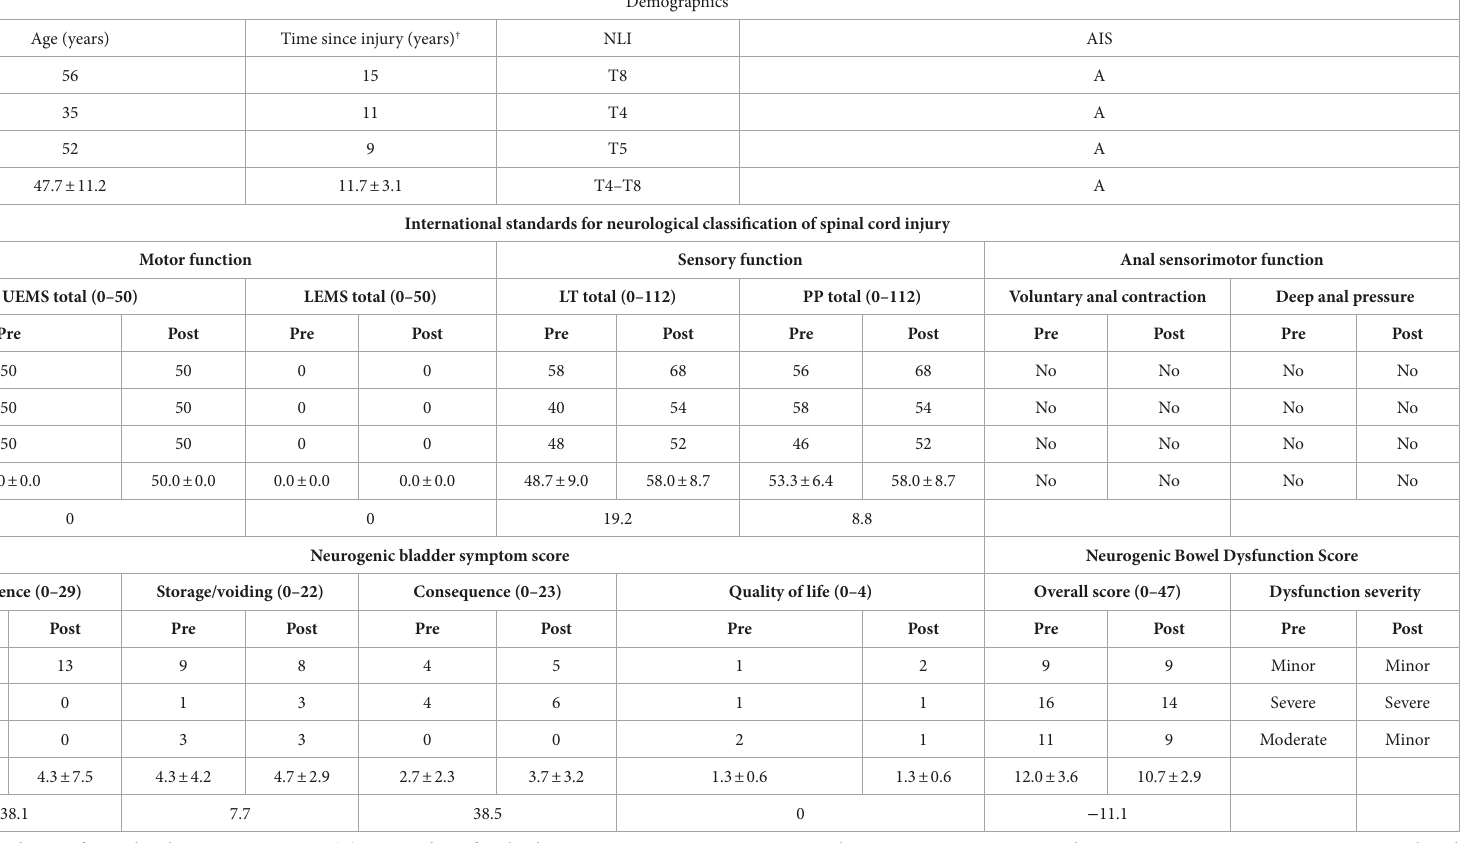
TABLE 1 Participant characteristics at baseline and